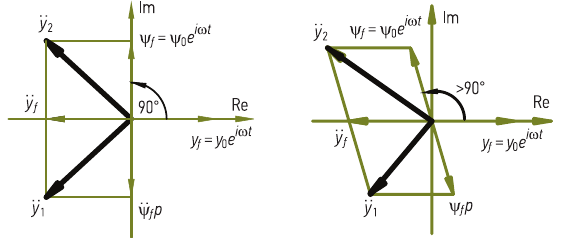
Fig. 8. The vector relationship of acceleration